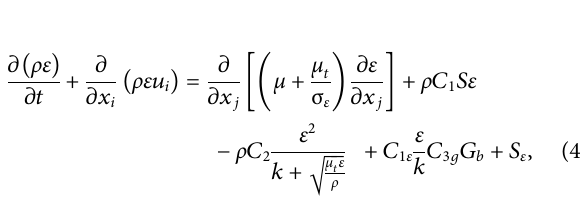
FIGURE 4 | Comparison between observed and simulated results: (A) velocity pro fi le; (B) sediment transport rate.